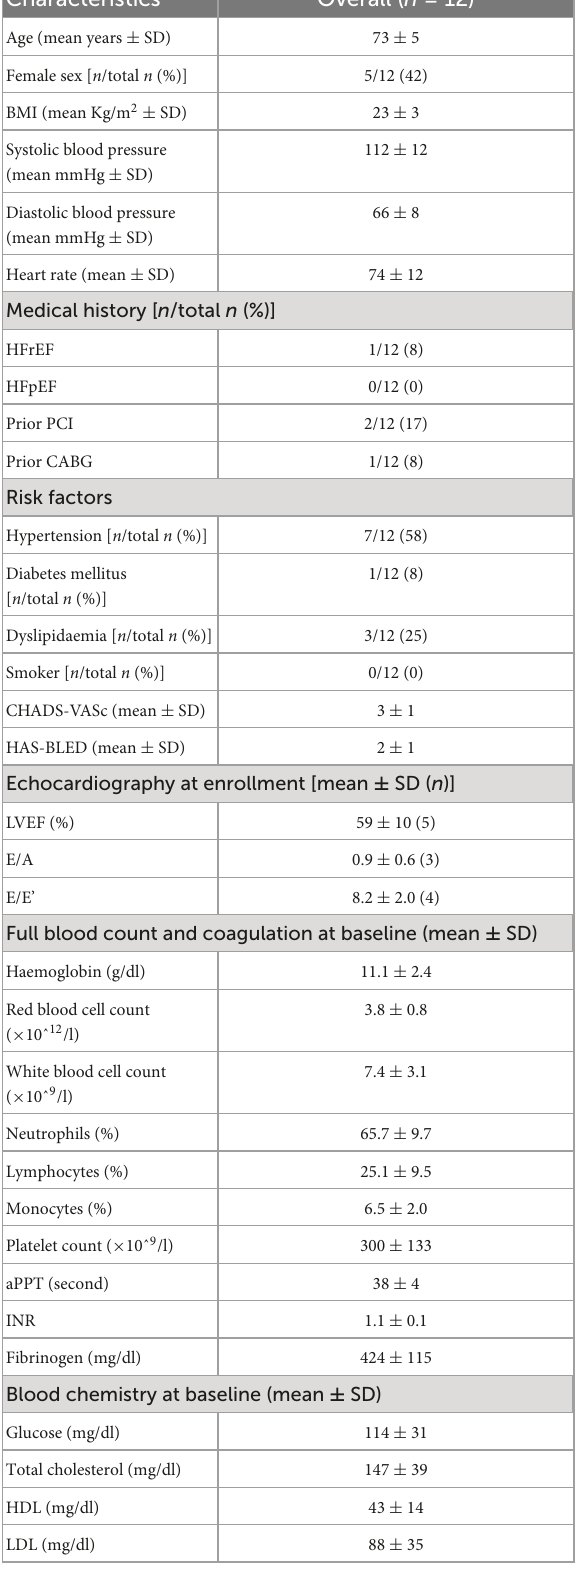
TABLE 2 Patients’ baseline characteristics. Characteristics